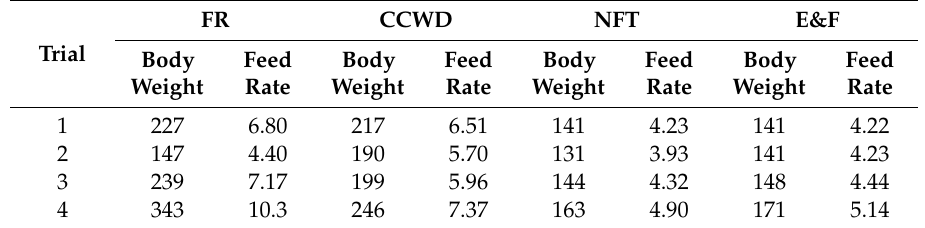
Table 2. The average body weight (g) and feeding rate (g) of red claw crayfish in each aquaponic growing systems throughout the